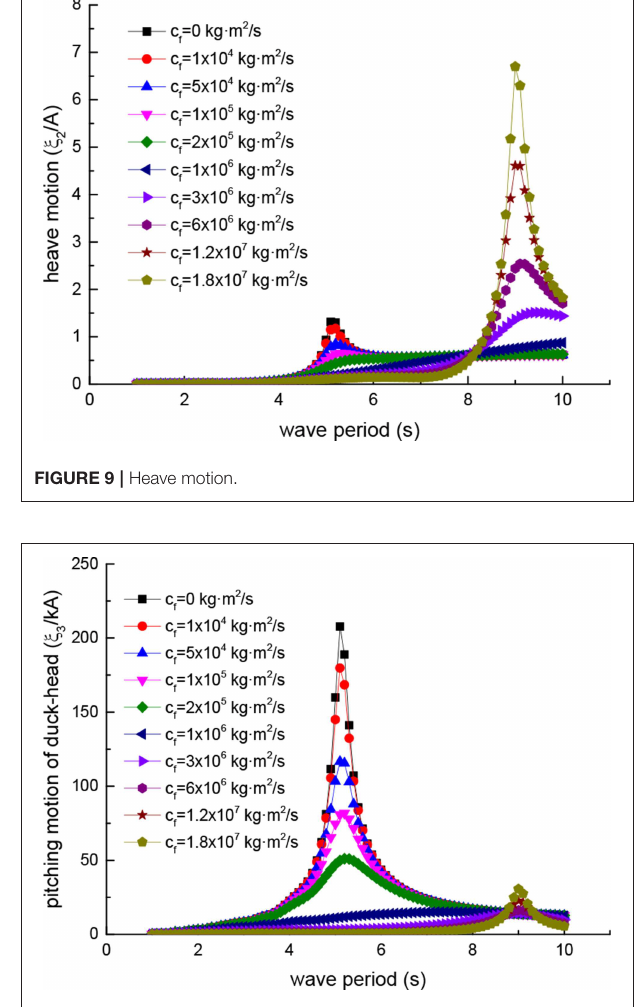
FIGURE 10 | Pitching motion of